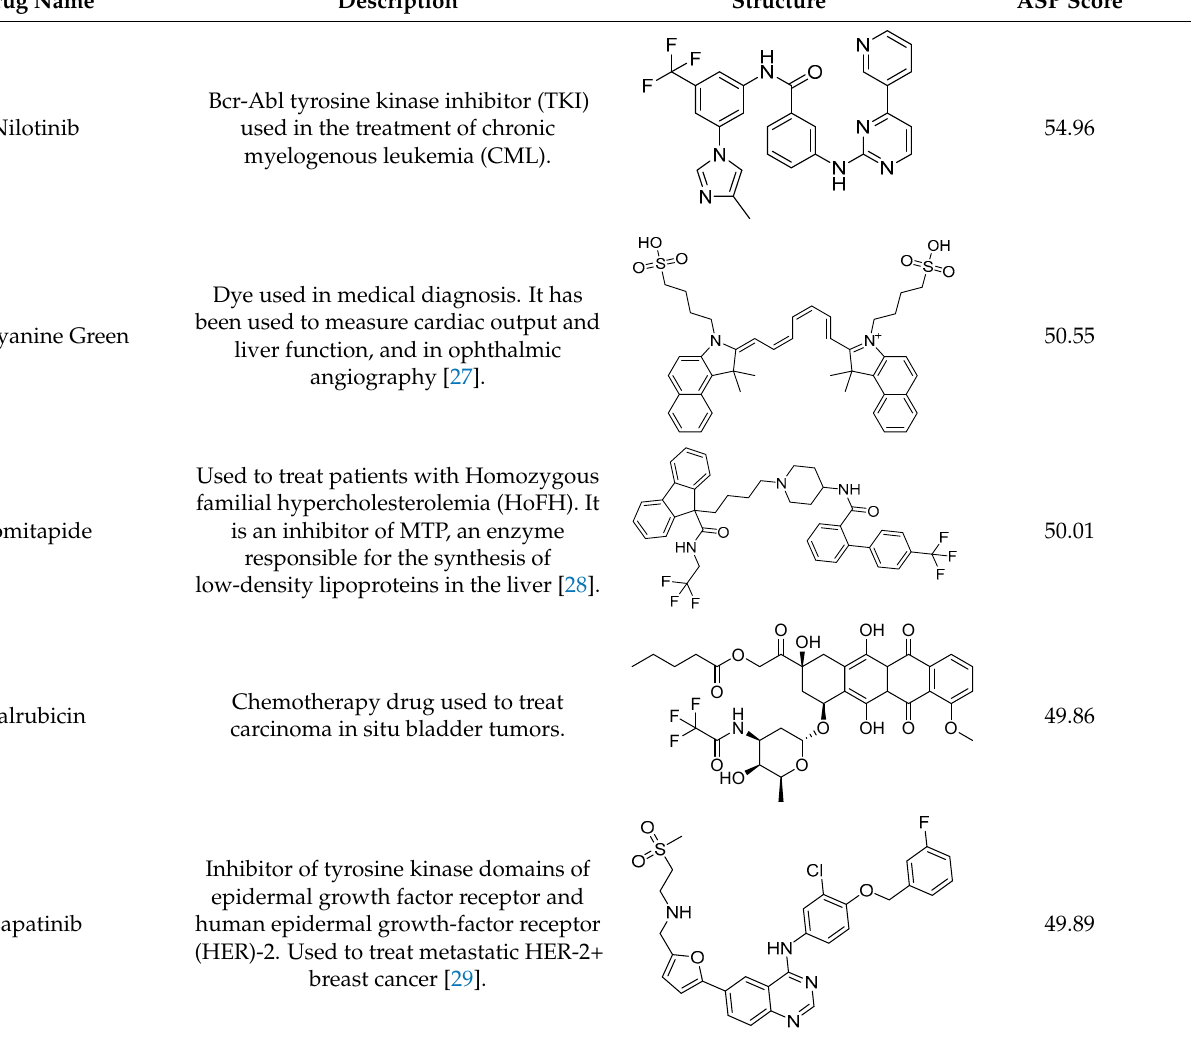
Table 3. Top 5 hits of the FDA-approved drugs database for MvfR.